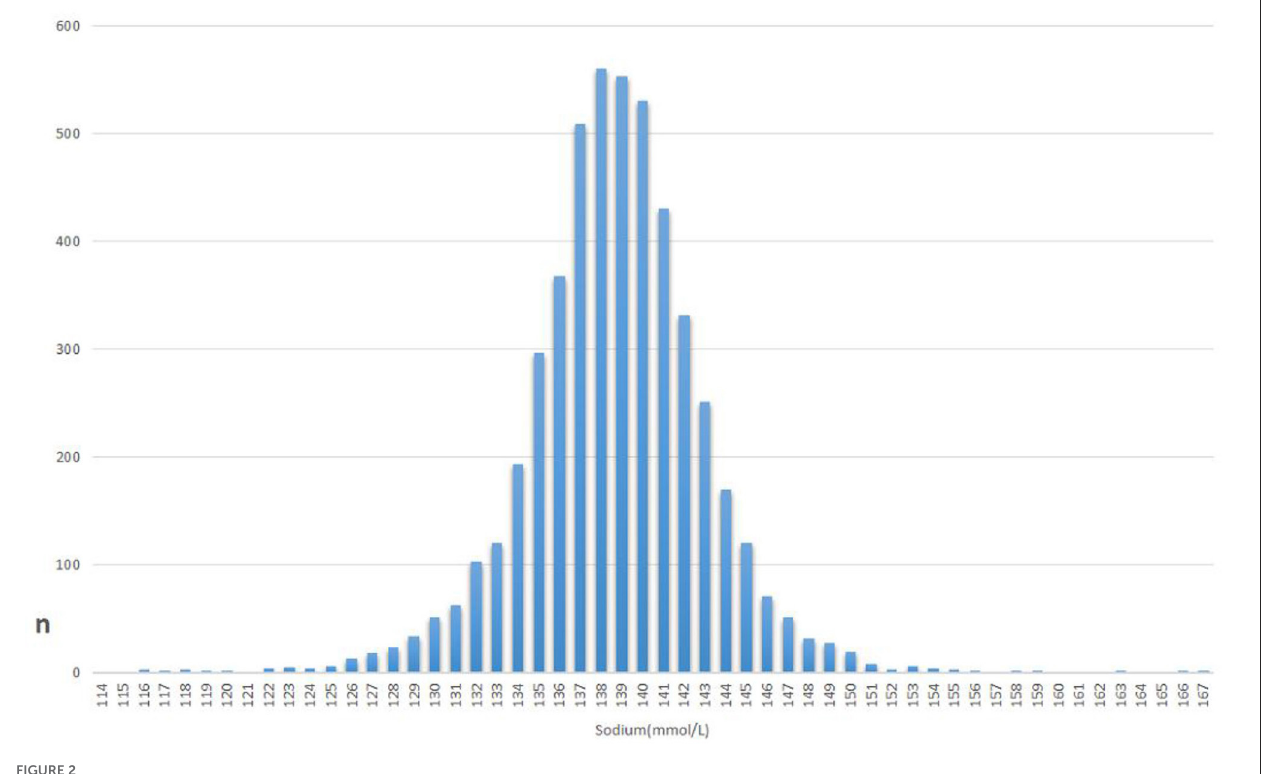
FIGURE2 The histogram of the number of patients and the serum sodium